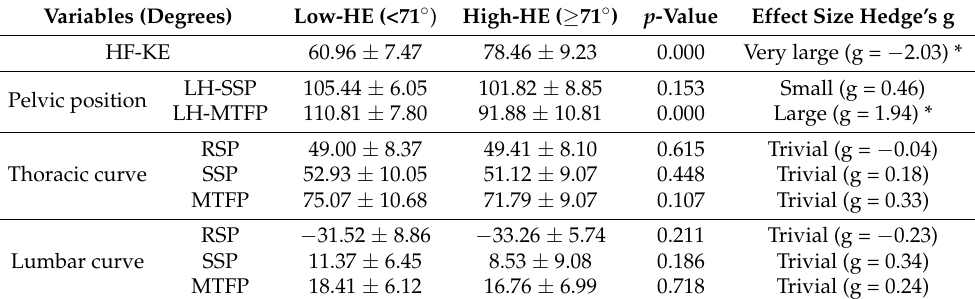
Table 2. Comparative analysis between low ( n = 27) and high ( n = 34) hamstring extensibility groups on sagittal pelvis position and spinal curve in male in soccer and basketball